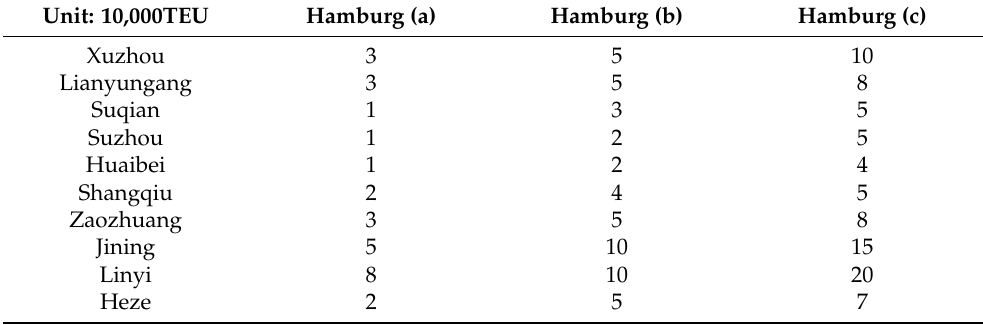
Table A6. Cross-border transportation uncertain demand between origin cities and Hamburg.